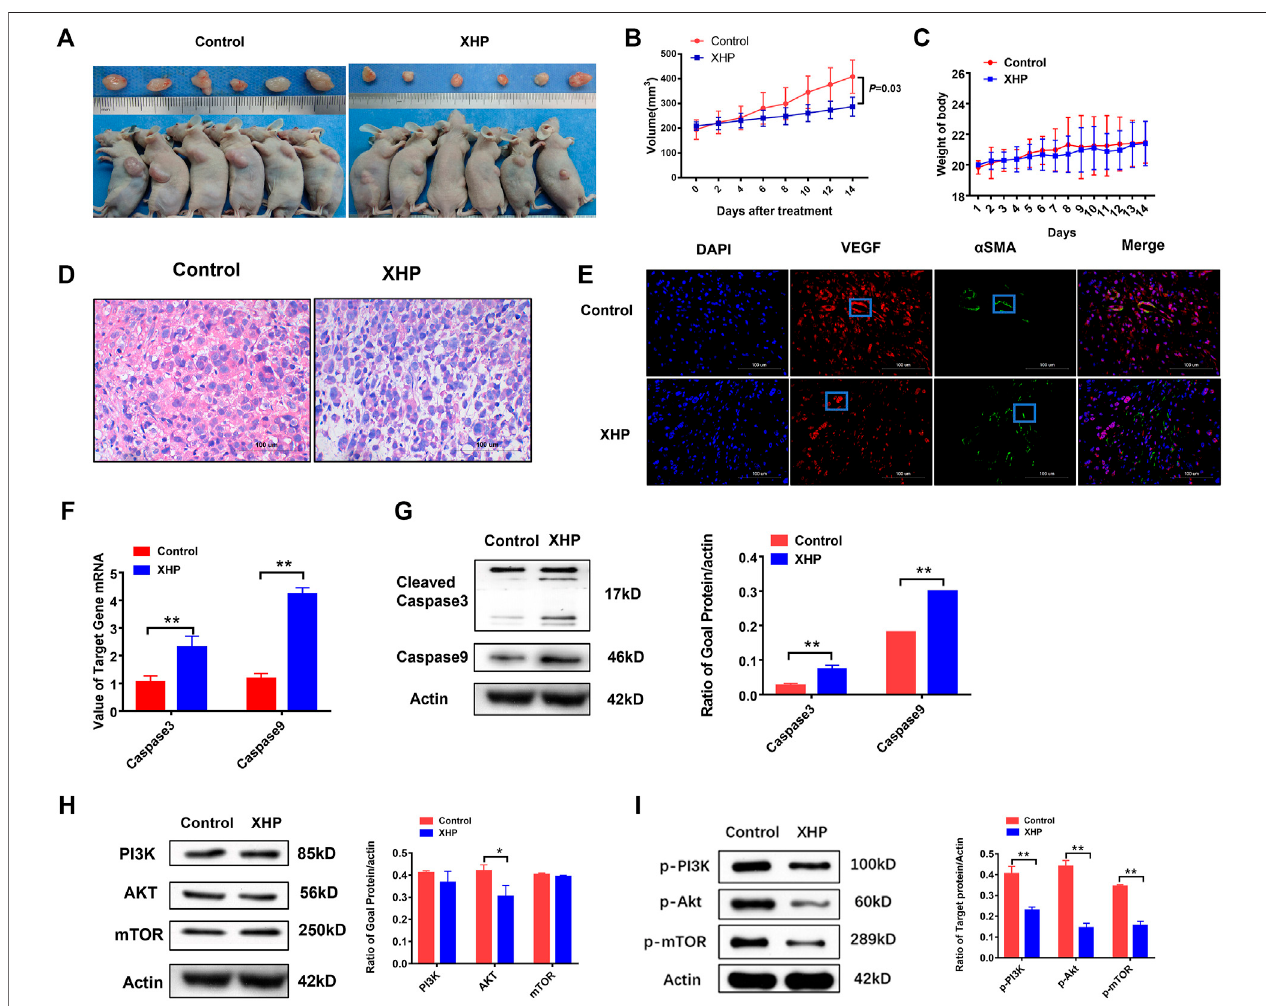
FIGURE 7 | (A,B) : The effect of XHP on the volume of prostate cancer PC3 subcutaneous transplantation; (C) : The effect of XHP Pill on the weight of prostate cancer PC3 subcutaneous transplantation mice; (D) : The effect of XHP on the pathological changes of prostate cancer PC3 subcutaneous transplantation in different groups; (E) :EffectsofXHPonVEGFand α SMAindifferentgroupsofprostatecancerPC3subcutaneoustransplantation.(TherednoderepresentstheVEGFsignal;The greennode representsthe α SMAsignal). (F,G) : Effect ofXHP ontheprotein and mRNAofcaspase3and caspase9 inPC3 subcutaneoustransplantation. (H) : The effect of XHP on PI3K, Akt, mTOR protein of prostate cancer PC3 subcutaneous transplantation; (I) : The effect of XHP on the protein of p-PI3k, p-Akt and p-mTOR in prostate cancer PC3 subcutaneous transplantation. (*Compared to the control group, p ≤ 0.05; **compared to the control group, p ≤ 0.01).